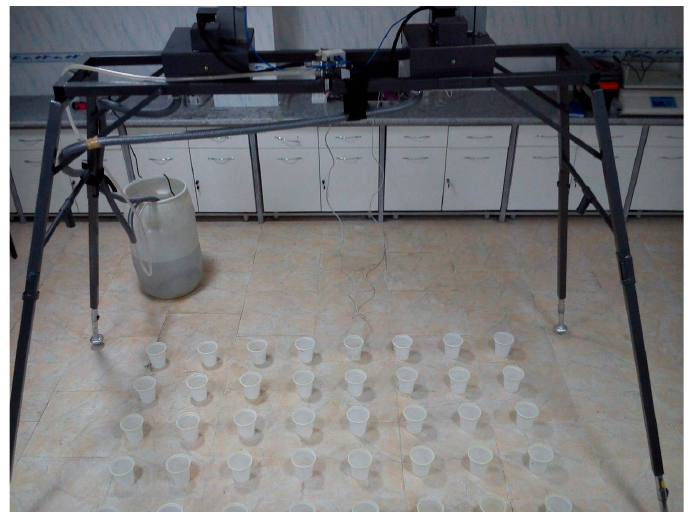
Figure 3. A view of the rainfall simulator at the laboratory of Sari University of Agricultural Sciences and Natural Resources.